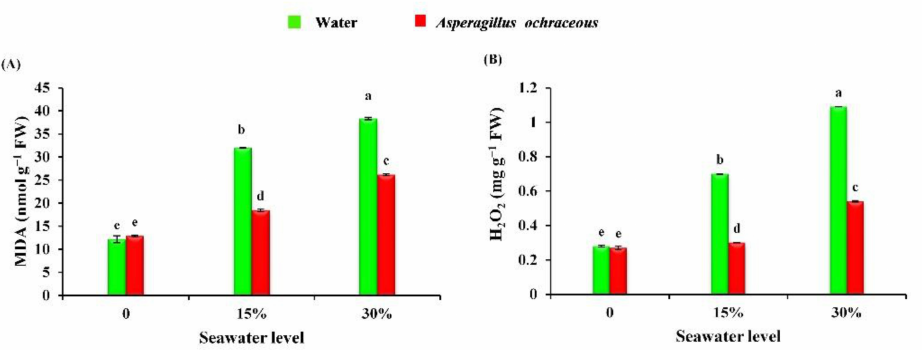
Figure 7. Effect of seawater irrigation, A. ochraceus application, and their interactions on the contents of ( A ) malondialdehyde (nmol g − 1 FW) and ( B ) hydrogen peroxide (mg g − 1 FW) in barley plants. Each bar represents the mean and standard error. The letters indicate significant differences between the treatments according to an LSD test at p < 0.05. FW: fresh